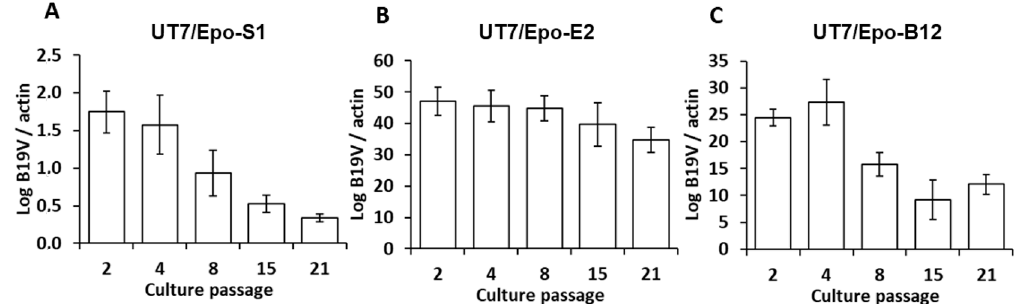
Figure 8. B19V permissivity throughout serial culture passage—UT7 / Epo-S1 cell line ( A ) E2 ( B ) and B12 ( C ) clones were maintained in culture during 67 days after thawing with up to 21 culture passages. At indicated time points, B19V permissivity was evaluated by measuring levels of VP2 mRNA and normalized with β -actin mRNA by the 2 − ∆ Ct method. The results shown are the means + SD of 3 independent